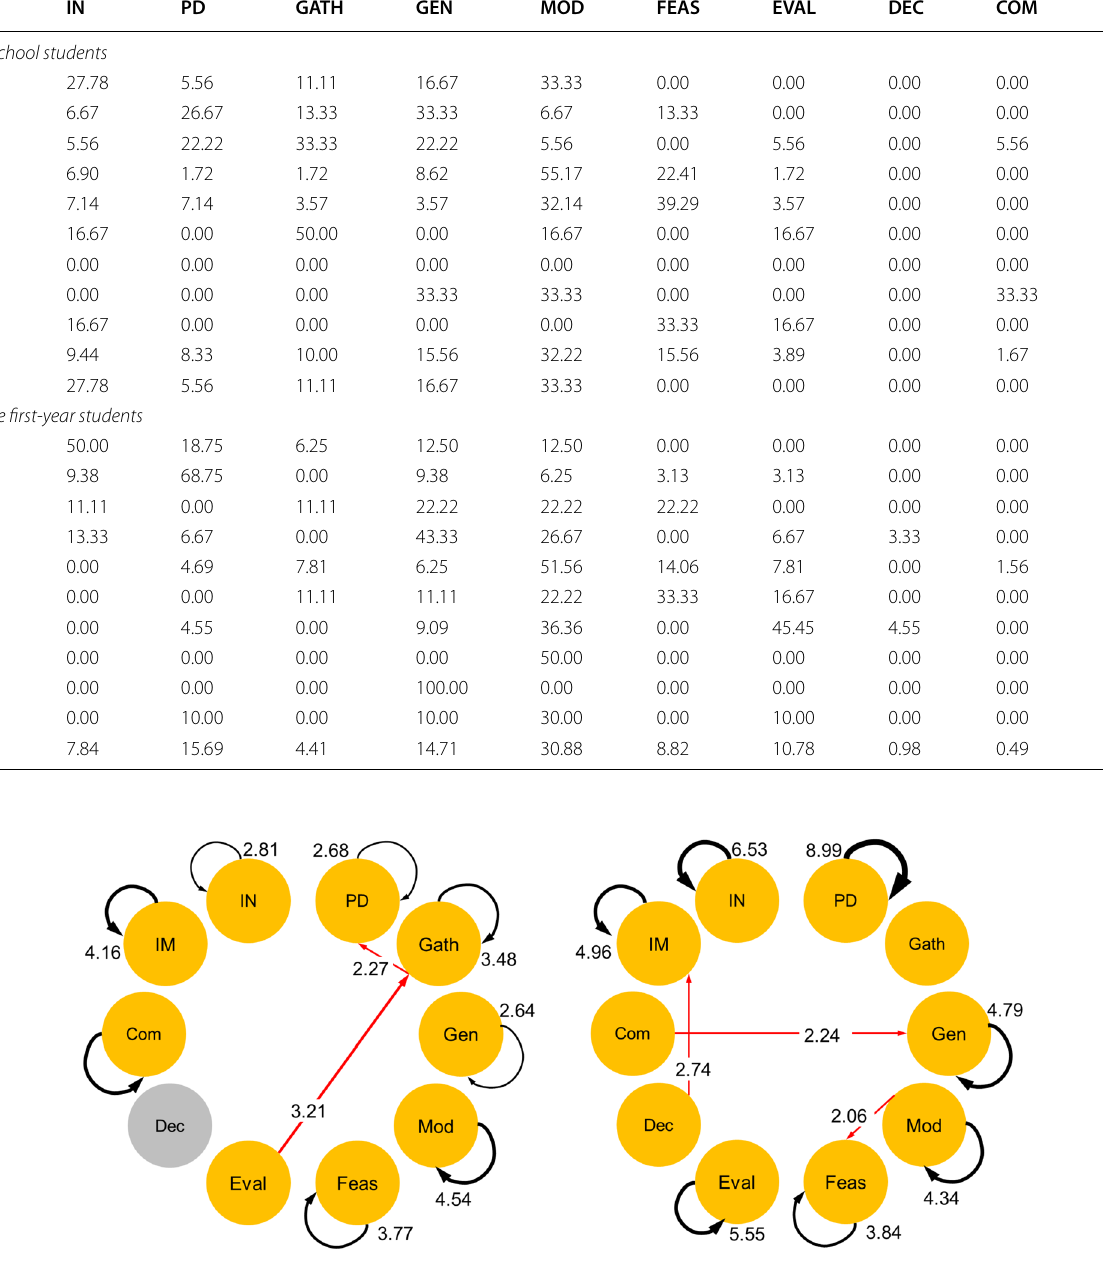
Table 4 Percentages of the self‑iterative and sequential transition behaviors for high school and college first‑year students IN PD GATH GEN MOD FEAS EVAL DEC COM IM